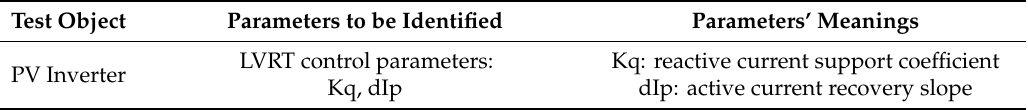
Table 1. Contents to be tested. LVRT—low voltage ride through;